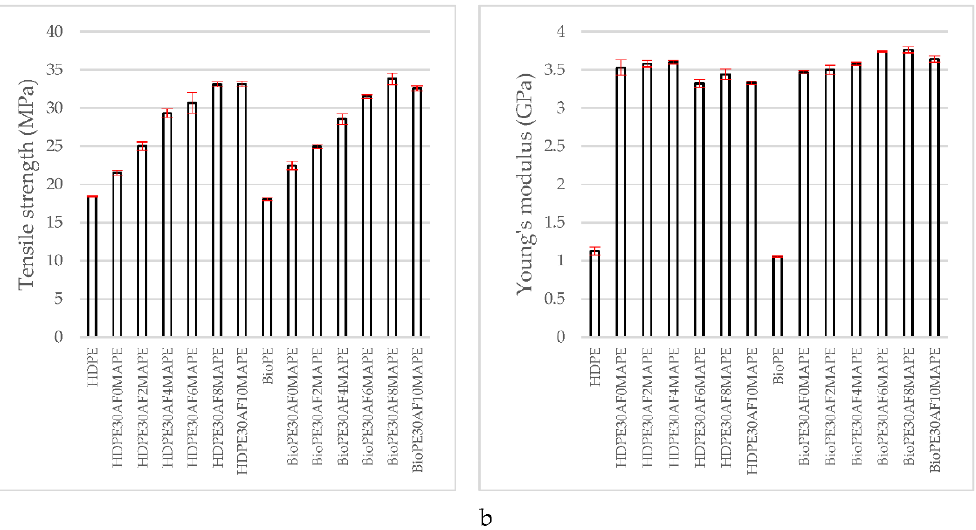
Figure 2. Evolution of the tensile properties of Abaca fiber reinforced HDPE composites against MAPE content: ( a ) Tensile strength; ( b ) Young’s modulus.